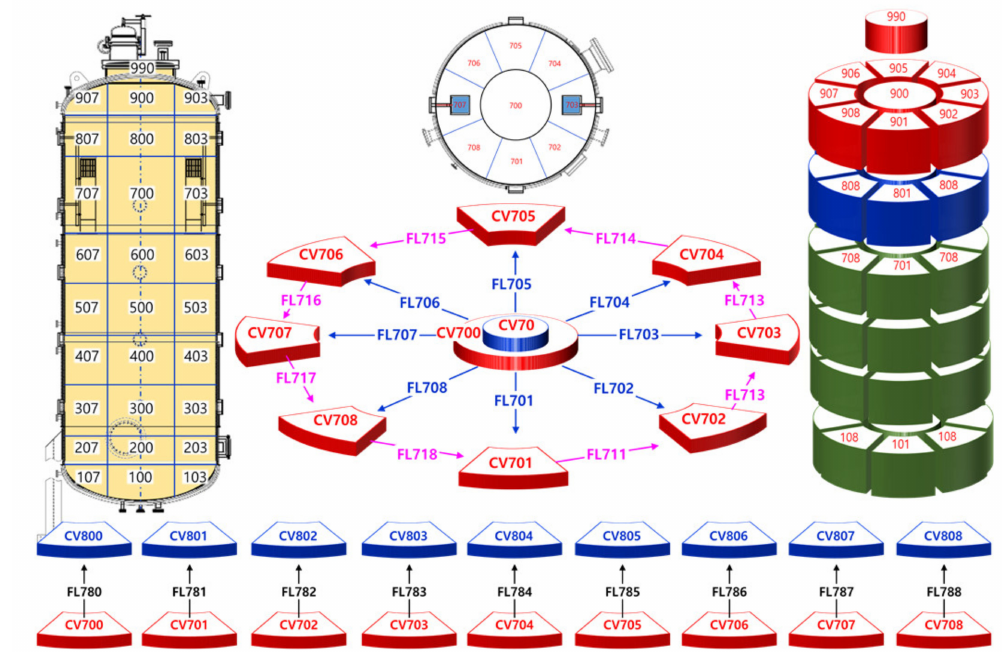
Figure 5. MELCOR nodalization scheme for base input of SPARC test